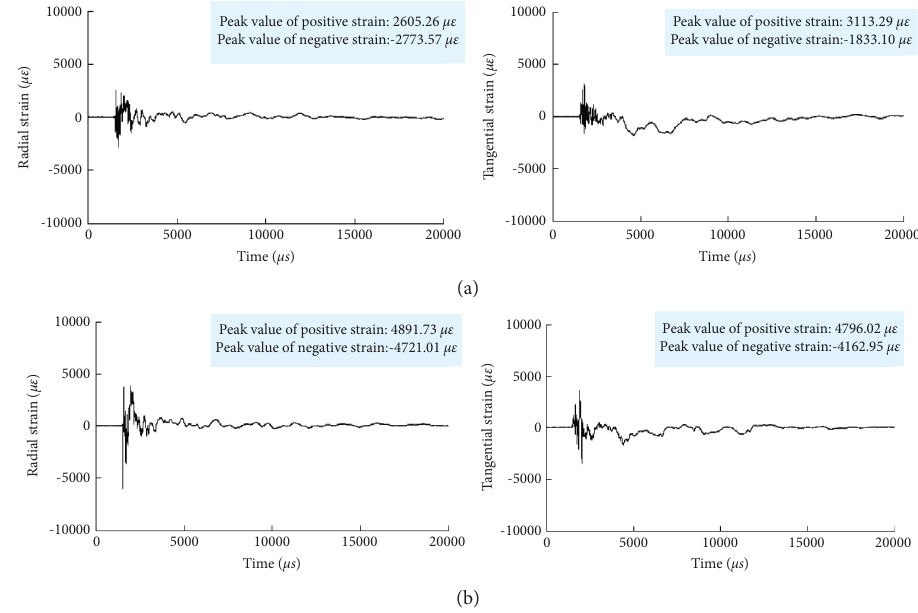
Figure 27: Explosion strain time history curves for case SN